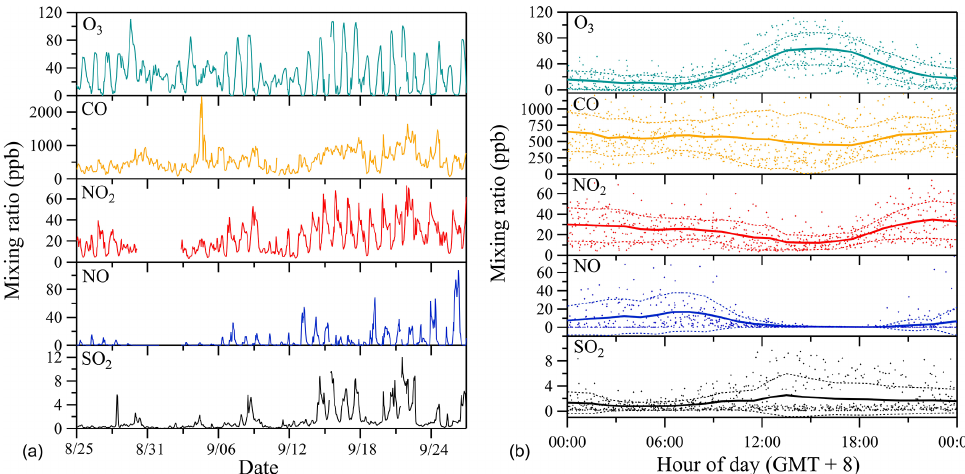
Figure 4. Time series of observed ambient air mixing ratios of prominent gas-phase pollutants (a) and respective mean diel courses (b) . In (b) , symbols denote individual hourly averaged data, and the thick solid lines respective mean diel profile. Thin dashed lines represent 1 standard deviation ( ± 1SD) from the mean